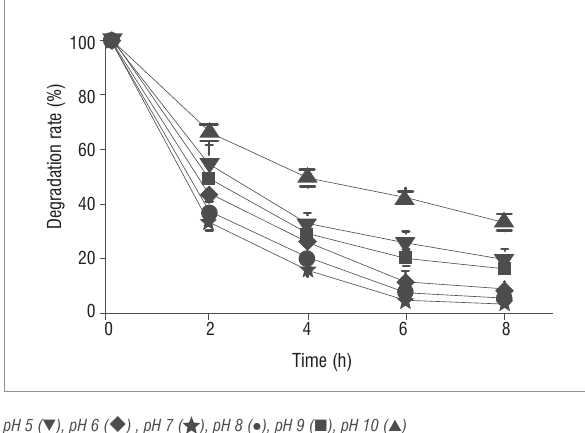
Figure 3: Effect of pH on the degradation of terephthalic acid by Arthrobacter sp.0574.